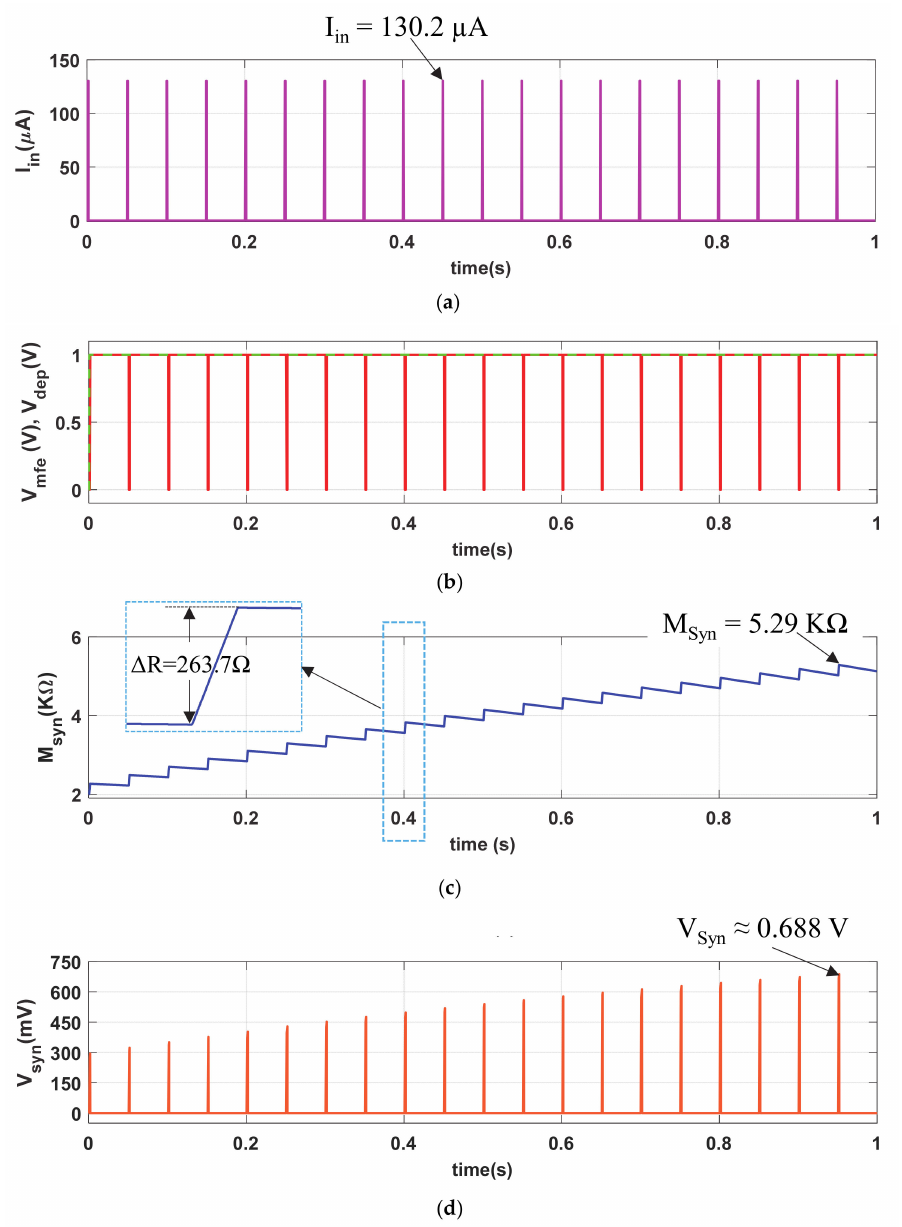
Figure 7. Strong stimulation response of neuro-memristive synapse. ( a ) Strong stimulus (I in ), ( b ) V mfe and V DEP signals, artificial ( c ) synaptic strength (M syn ), and ( d ) synaptic voltage (V syn